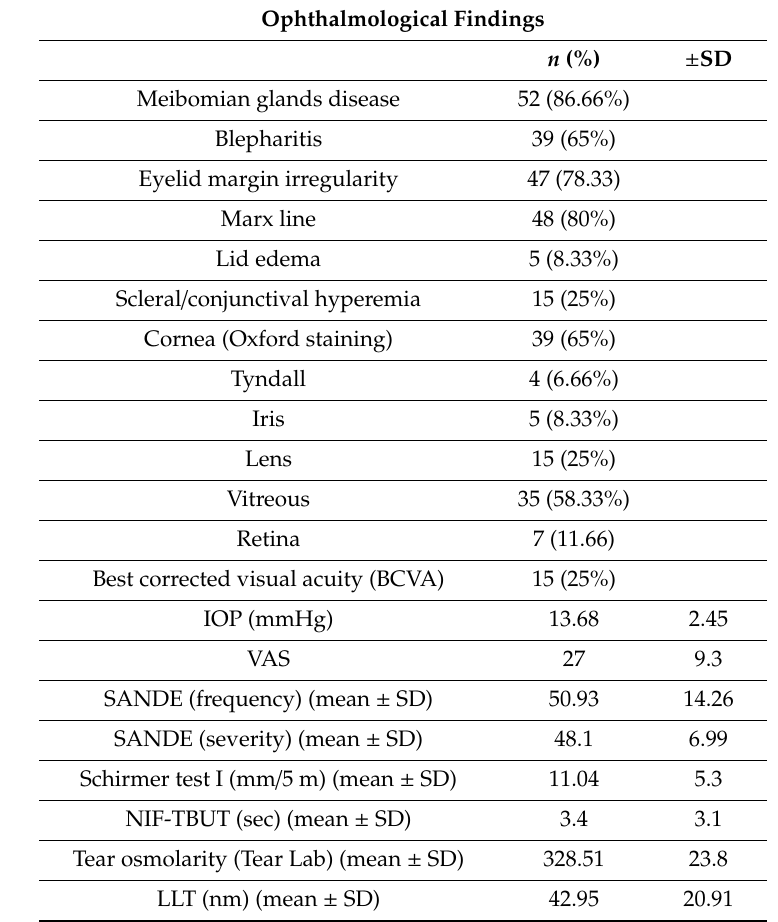
Table 2. Ophthalmological